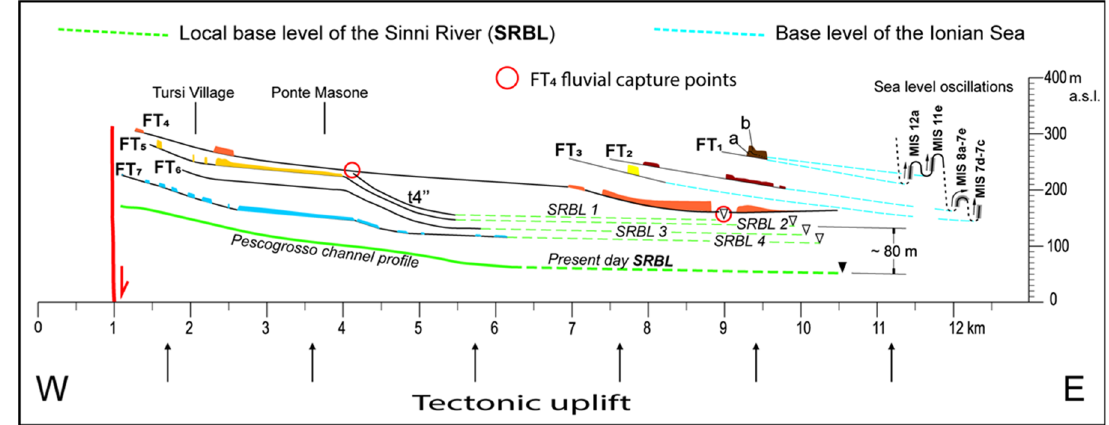
Figure 13. Plot of fluvial terraces profiles and correlation with the regional base level, corresponding to the Ionian Sea, and the local base level, corresponding to the Sinni River. It is also shown as the FT 1 , FT 2 , and FT 3 terraces were influenced by highstand/lowstand oscillation of the Ionian sea level within the MIS variations. the MIS